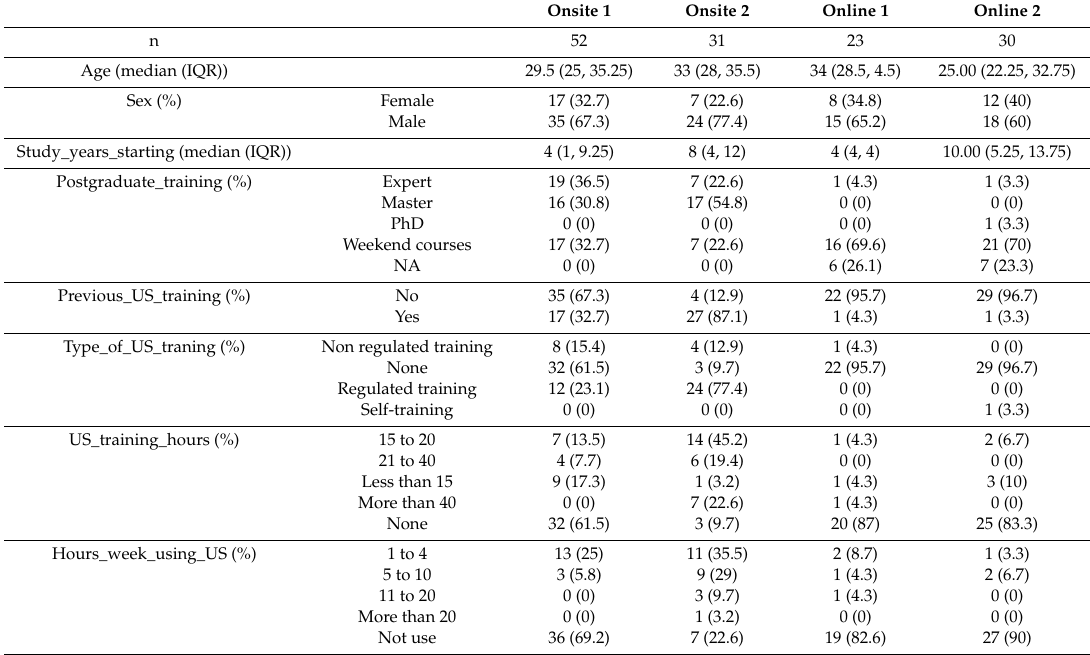
Table 1. Baseline characteristics of the sample.